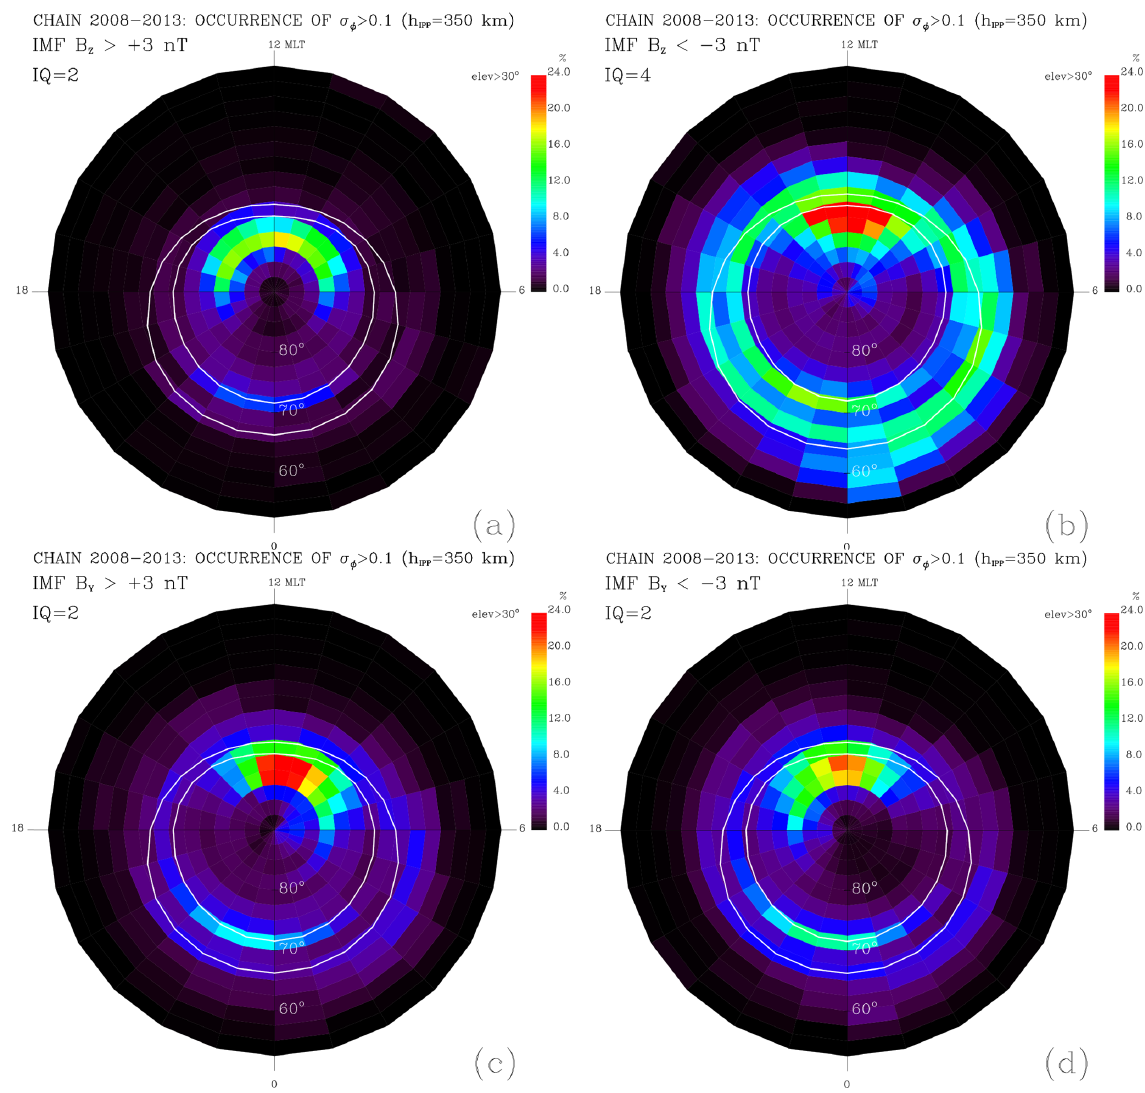
Figure 8. The 2008–2013 phase scintillation occurrence maps for (a) B Z > + 3nT, (b) B Z < − 3nT, (c) B Y > + 3nT and (d) B Y < −